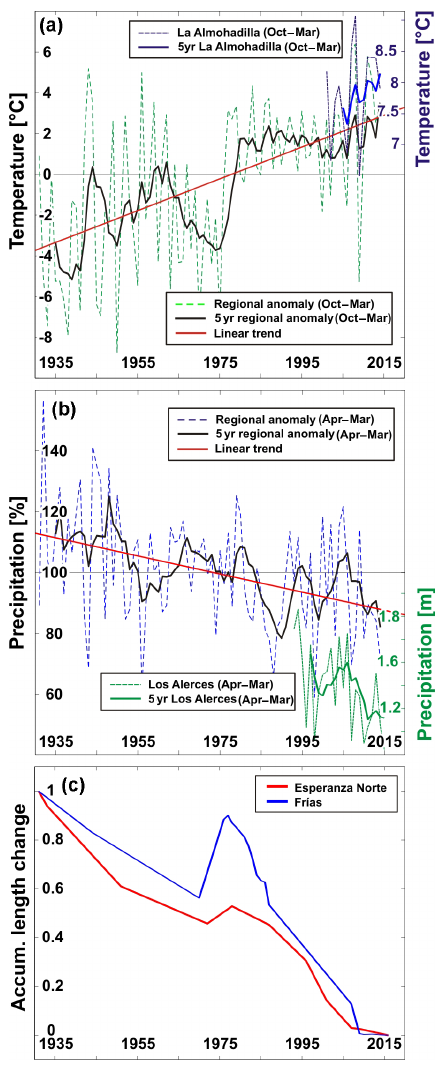
Figure 6. (a) Warm season (October–March) temperature anomaly series derived from six selected stations in the northern Patagonian region. The linear trend and a 5-year moving average are shown to highlight the low-frequency patterns in this series. The temperature record in La Almohadilla, the closest temperature record to Monte Tronador is also shown. (b) Same as (a) , but for April to March pre- cipitation variations in this region. The precipitation record in Los Alerces, the closest precipitation record to Monte Tronador is also shown (c) Length changes of Frías and Esperanza Norte glaciers, updated from Leclercq et al., 2012; Ruiz et al., 2012. Esperanza Norte is also a clean ice glacier located ca. 100km south of Tron- ador (Ruiz et al., 2012). Note the overall retreating pattern is only interrupted by re-advances in the late